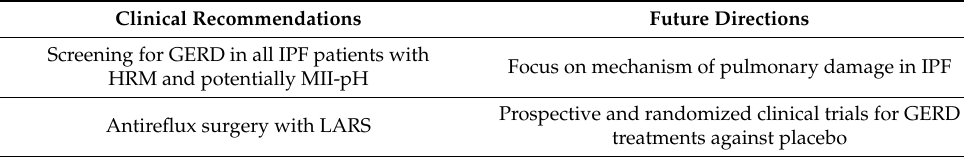
Table 3. Clinical recommendations and future directions for GERD-IPF